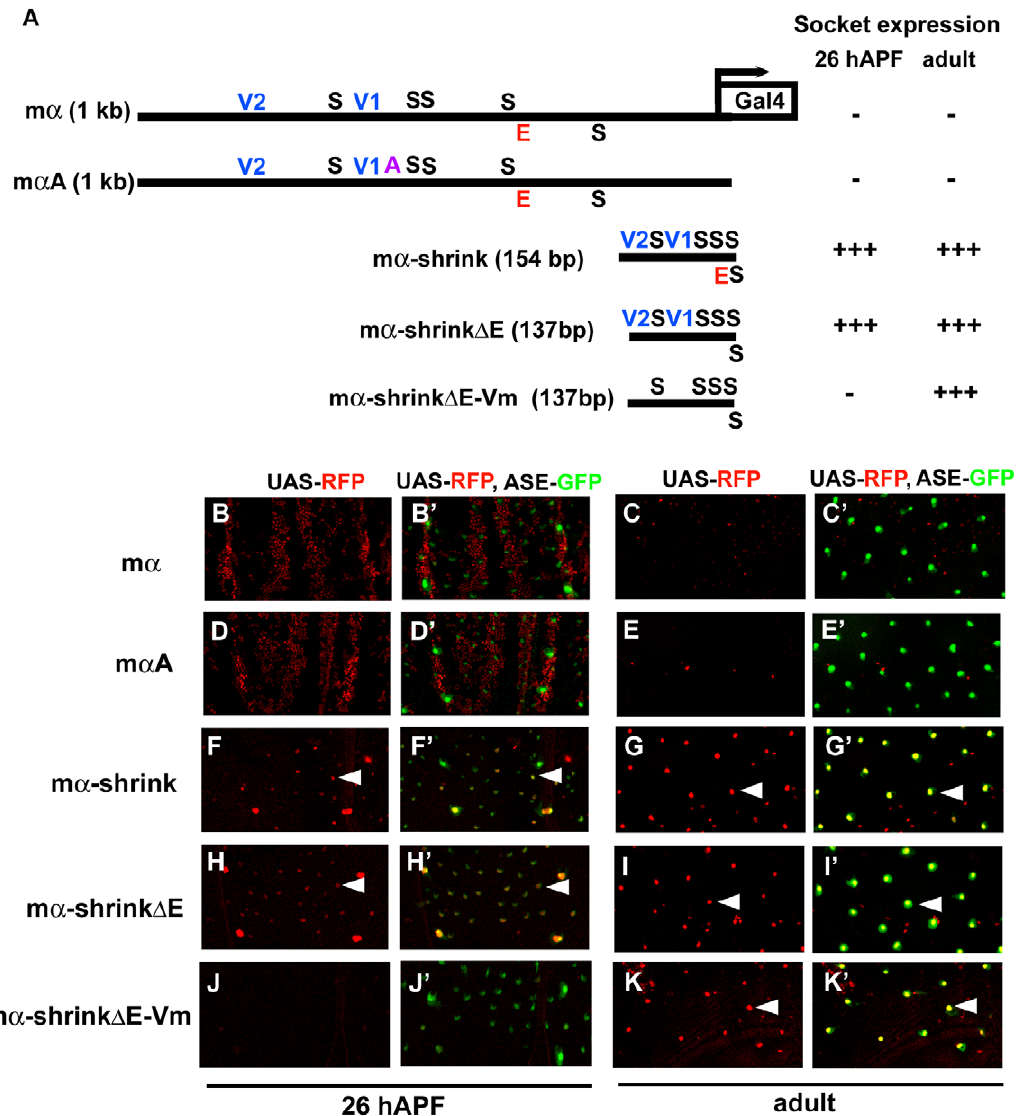
Figure 6. Condensed spacing of transcription factor motifs converts the cell-type specificity of the m a enhancer. (A) Diagrams of the wild-type m a enhancer and variants. The module’s five Su(H) sites (S) are in black; the ‘‘E box’’ proneural protein binding site (E) is in red; the two Vvl (POU-HD/homeodomain) sites (V1, V2) are in blue; the A motif from ASE5 (AACGCGAAGCT; see Figure 1B) is in purple. m a A is the same construct shown in Figure 5; the m a -shrink series are synthetic enhancer constructs that include the known essential transcription factor binding sites of the wild-type m a enhancer. RFP expression driven by each construct (using the GAL4-UAS system) in either nascent (pupal-stage; 26 hours APF) or mature (adult) socket cells is summarized at right. (B–K, B 9 –K 9 ) RFP expression (red) driven by m a enhancer constructs in pupal nota at 26 hours APF (B, B 9 ; D, D 9 ; F, F 9 ; H, H 9 ; J, J 9 ) and dorsal epithelium of adult abdomen (C, C 9 ; E, E 9 ; G, G 9 ; I, I 9 ; K, K 9 ). In merged images (B 9 –K 9 ), socket cells are identified by expression of an ASE-GFP reporter gene (green) [10]. Arrowheads indicate examples of RFP-expressing socket cells. Both the wild-type m a enhancer (m a ) and the m a A variant display residual activity in the non-SOP cells of microchaete proneural clusters of the pupal notum (B, B 9 ; D, D 9 ), but are inactive in both nascent and mature socket cells (B–E, B 9 –E 9 ). By contrast, the ‘‘wild-type’’ synthetic construct m a -shrink lacks proneural cluster activity (F, F 9 ) and instead drives robust expression in socket cells at both stages (F–G, F 9 –G 9 ). This activity does not require the E box motif (m a -shrink D E; H–I, H 9 –I 9 ), but mutation of the Vvl sites eliminates activity in nascent socket cells (m a -shrink D E-Vm; J, J 9 ). As in the case of the ‘‘ABm’’ version of ASE5-shrink (see Figure 3), the five Su(H) sites of the m a enhancer are sufficient to drive expression in adult socket cells when brought sufficiently close together (K, K 9